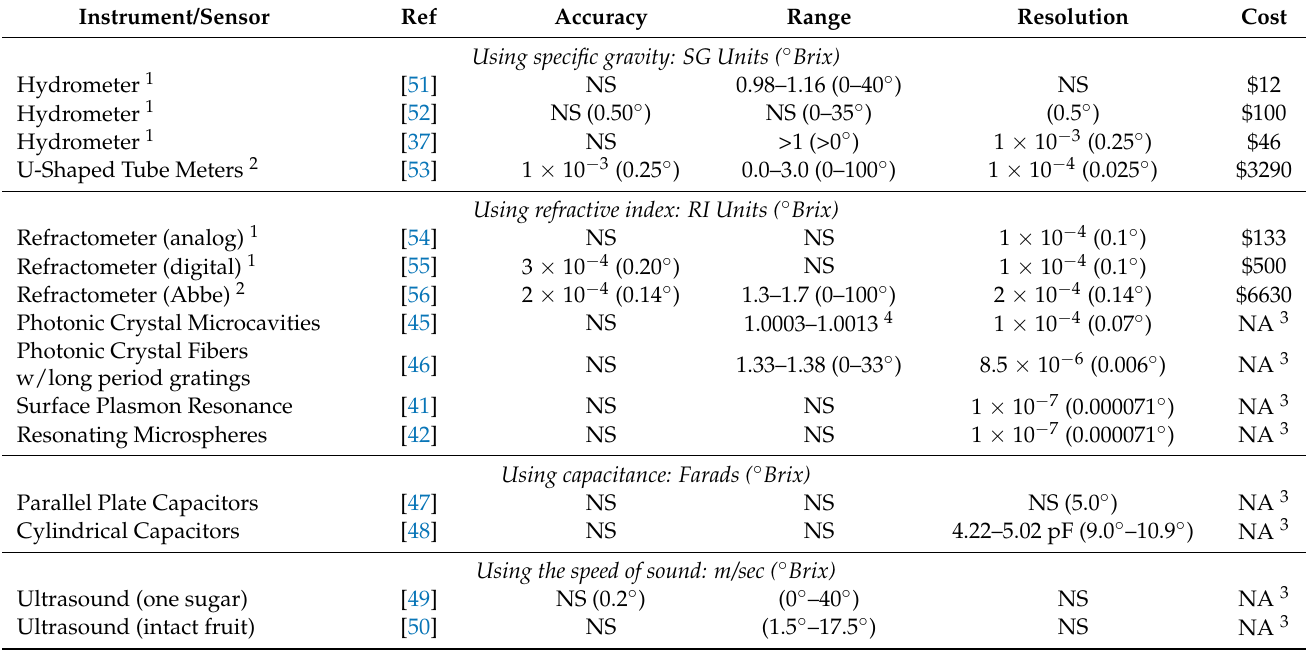
Table 4. Sensors for Measuring Sugar Content in Fruit and Fruit Juice (NS: not